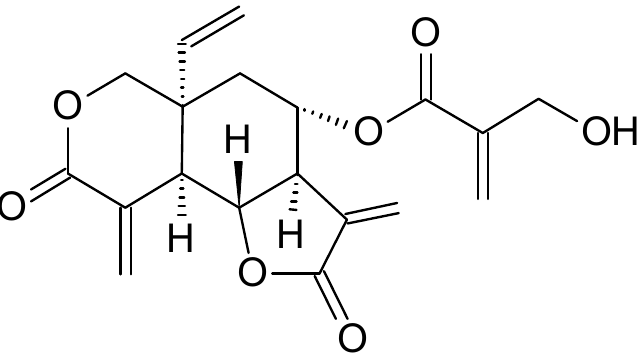
Figure 6. The structure of vernodalin.